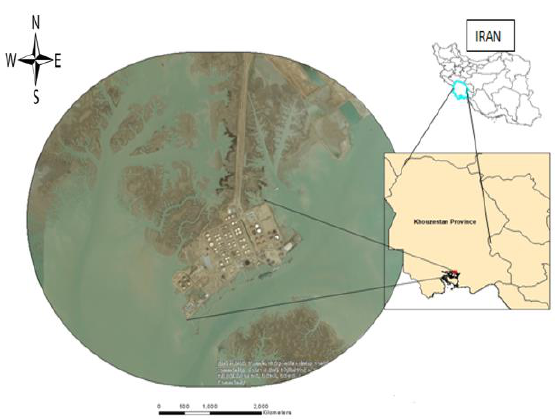
Fig. 1. Location of Mahshahr export port in Khormousa, Khuzestan province, south of